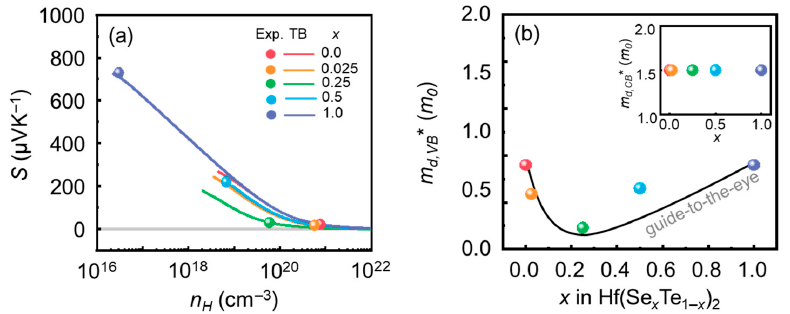
Figure 1. ( a ) Experimental (symbols) and theoretical (lines) S in terms of n H for Hf(Te 1 − x Se x ) 2 ( x = 0.0, 0.025, 0.25, 0.5, and 1.0) at 300 K [22], ( b ) estimated m d , VB * (= m d * for holes) in terms of Se alloying content ( x ) at 300 K. The x -dependent m d , CB * (= m d * for electrons) at 300 K is provided in the